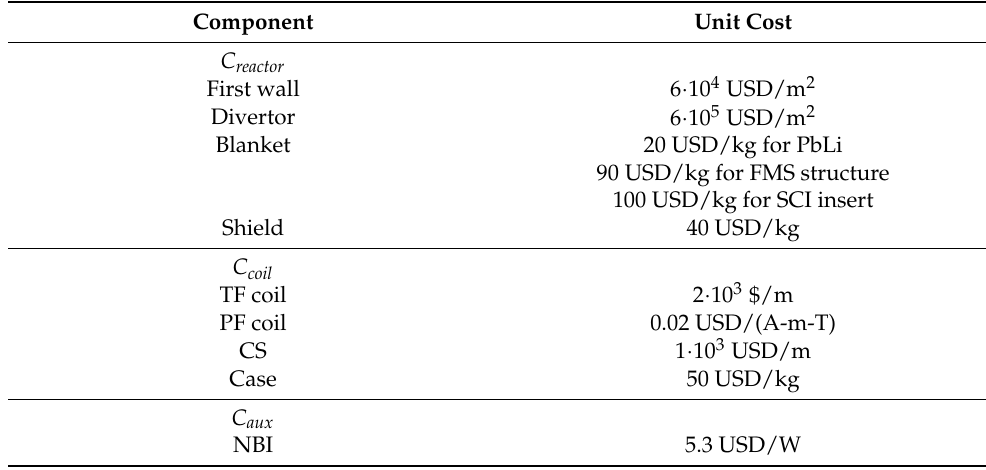
Table 2. Unit costs used for the cost